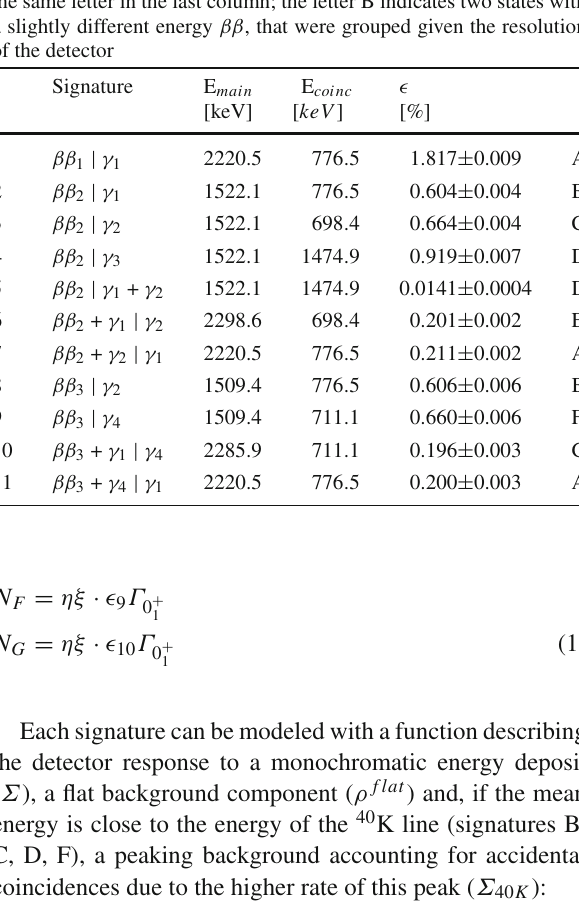
Table 1 Signatures of the 82 Se decays to the excited states of 82 Kr, grouped according to the decay level: ββ is the energy carried away by electrons in the decay to the 2 + state ( ββ 1 ), to the 2 + state ( ββ 2 ), or to 1 2 the 0 + state ( ββ 3 ); γ i are the γ rays emitted in the de-excitation to the 1 ground state (Fig. 1); the vertical bar separates the particles releasing their full energy (E main ) in the 1 st crystal, and the particles releasing their full energy (E coinc ) in the second crystal.The detection efficiency (cid:10) is determined by a Monte Carlo simulation. Different decay schemes resulting in the same signature (for example, 1, 7, 11) are labelled with the same letter in the last column; the letter B indicates two states